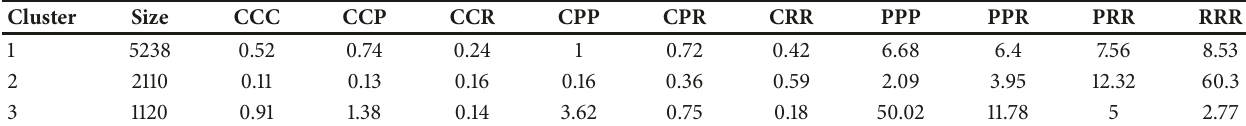
Figure 13: Example of process model for cluster #3 using n-gram analysis. Table 1: Mean of activities’ combinations for users’